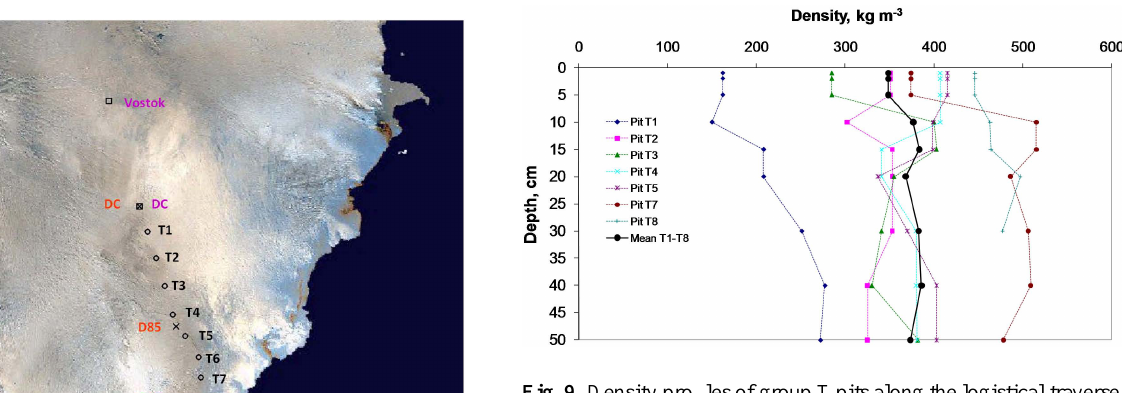
Fig. 9. Density profiles of group T pits along the logistical traverse.